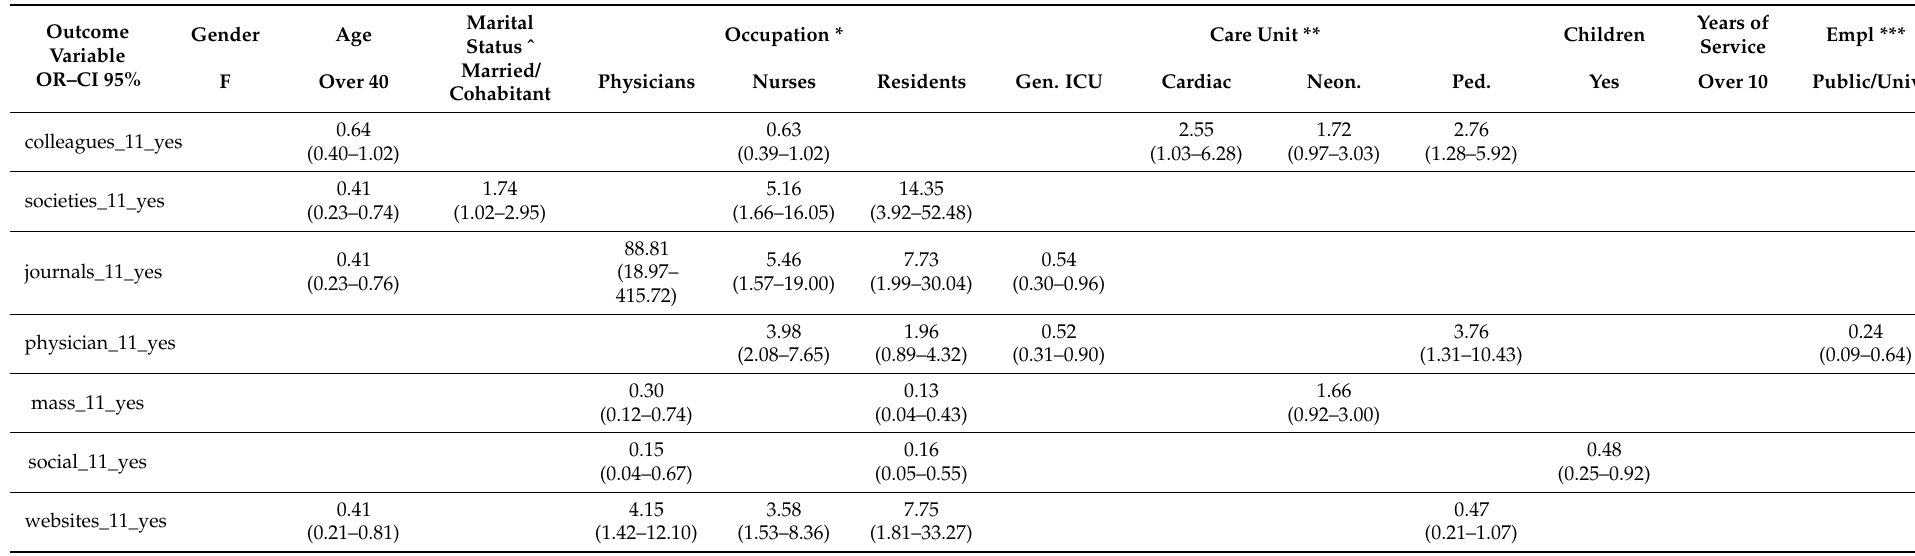
Table 8. Results of multivariate analysis—OR (95%CI) positive answers—source of information. Outcome